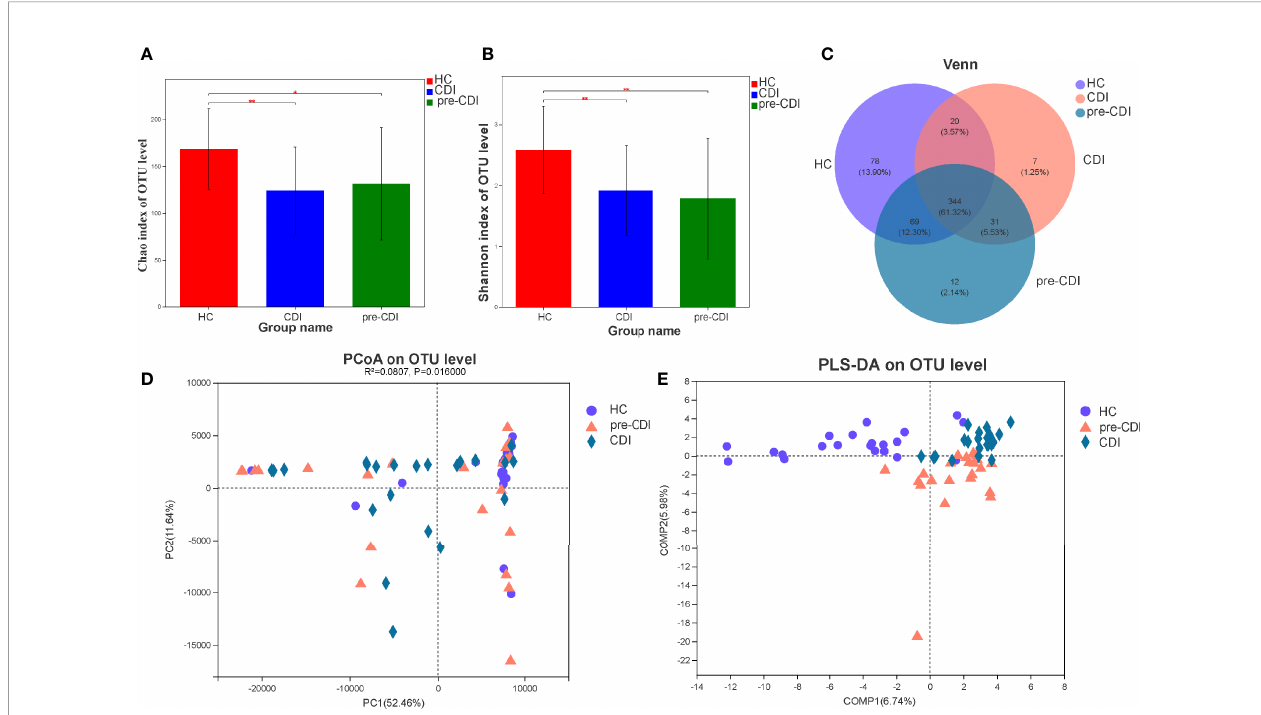
FIGURE 1 | Structural comparison offecal microbiota in the CDI, pre-CDI and HC groups. (A) The Chao1 and (B) Shannon indices were used to estimate abundance and diversity of the gut microbiota in patients (data are shown as the mean with SD). (C) A Venn diagram describing the overlap of OTUs in gut microbiome among the three groups. (D) PCoA of Euclidean distances at the OTU level. (E) PLS-DA score plot of gut microbiota among the three groups. *P < 0.05; **P <